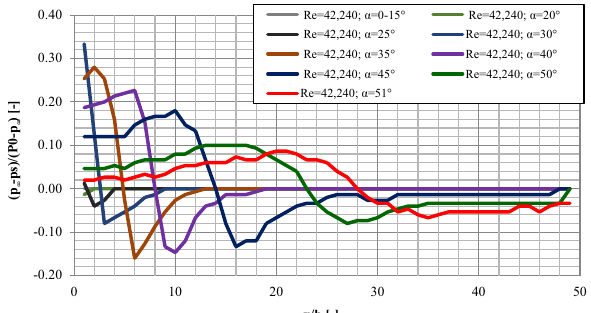
Figure 6. The pressure distributions on the plate—examined in the direction of detachment Re = 42,240; (where static pressure (ps); the pressure of maximal airstream (P 0 ); static pressure of the surrounding fluid at rest (p∞)).